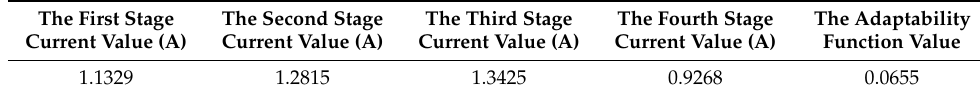
Table 2. Simulation results of four-stage constant current charging strategy.